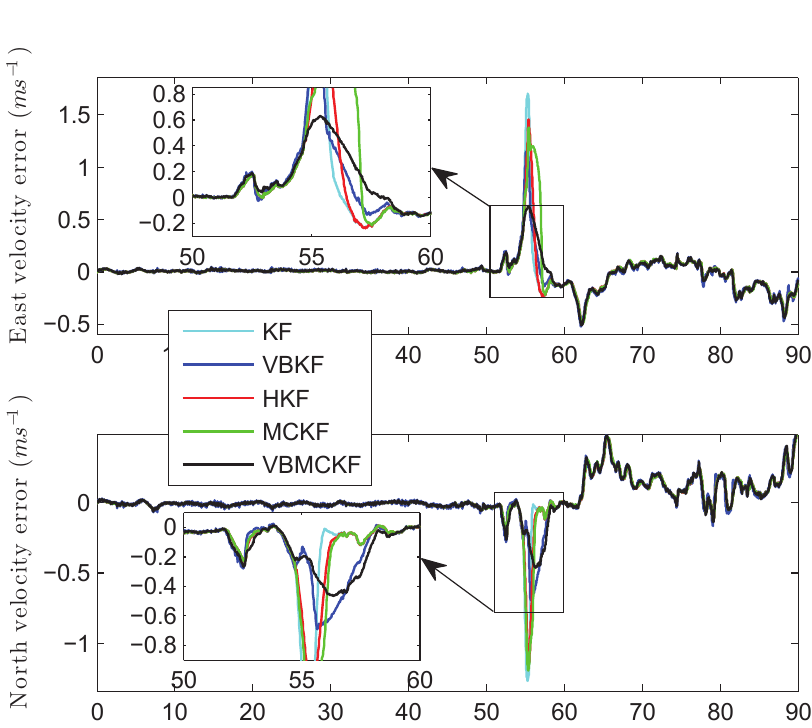
Figure 9. Velocity errors of different